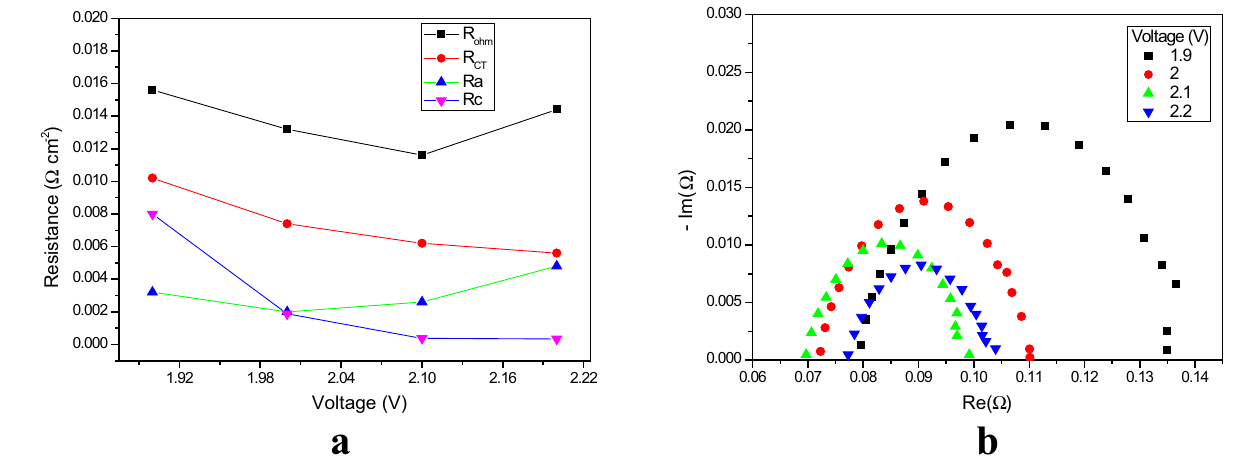
Figure 4. (a) Nyquist plots of EIS measurements (from 100 kHz to 1 MHz), at amplitude 50 mA, as a function of higher voltages. ( b) Variation in the relevant electrochemical resistances as a function of higher